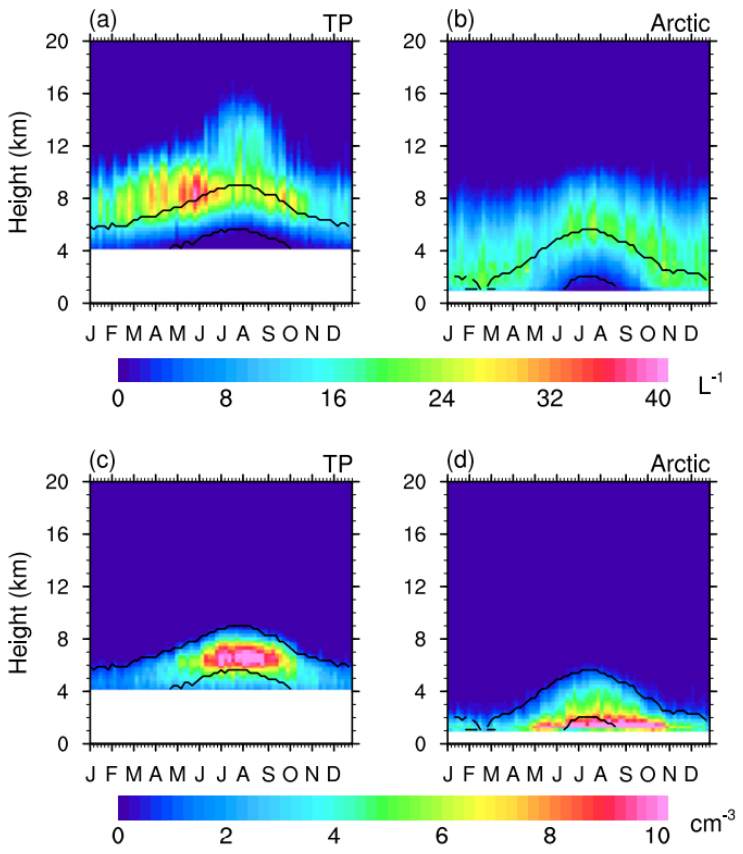
Figure 1. Seasonal cycle of the vertical distribution of the cloud ice ( upper panels ) and liquid ( lower panels ) number concentrations over the Tibetan Plateau (TP; left panels ) and the Arctic ( right pan- els ). The upper and lower black lines in each plot represent the climatic locations of − 20 and 0 °C that are calculated from the ECMWF–aux (version r04) product.